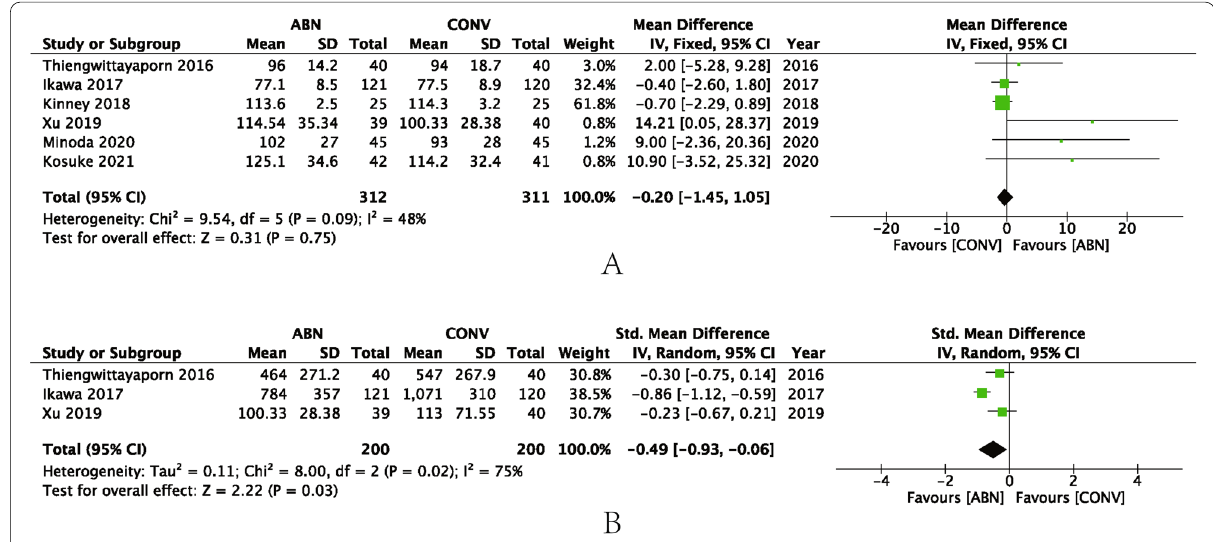
Fig. 7 A Forest plot of duration of surgery; B Forest plot of blood loss